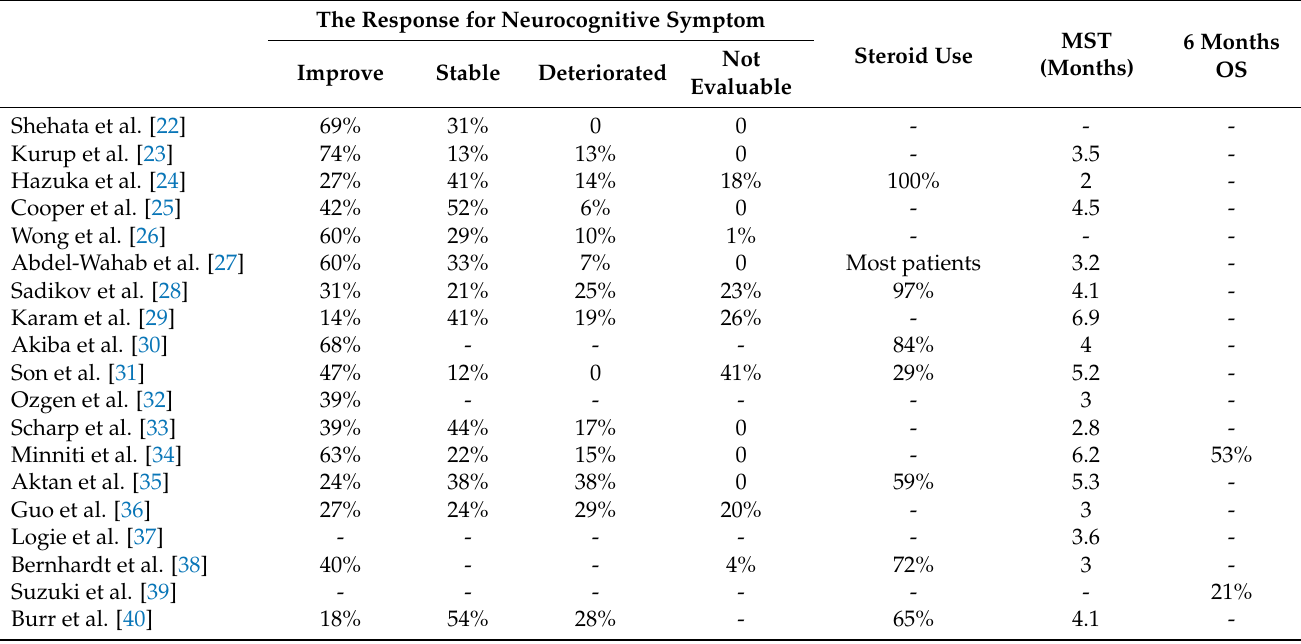
Table 2. The efficacy of re-whole brain